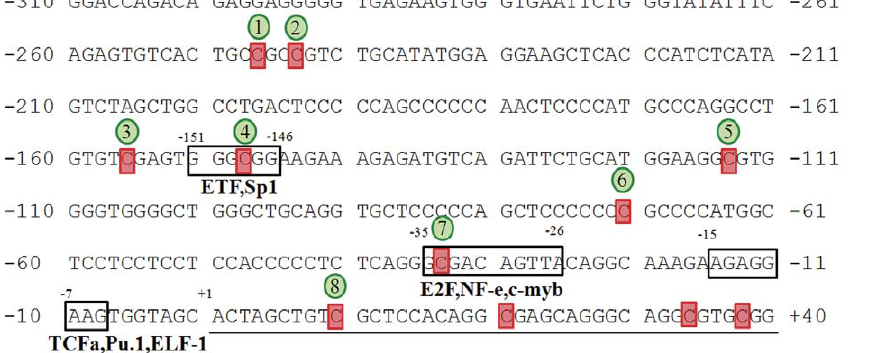
Figure 1. Nucleotide sequence of the 5 9 minimal regulatory region of the human vav 1 gene. Boxes indicate putative binding sites for various transcription factors as predicted by bioinformatics. Their location is indicated relative to the transcription start site ( + 1 position). Putative sites for CpG methylation are highlighted in red, their arbitrary serial numbers are circled in green.